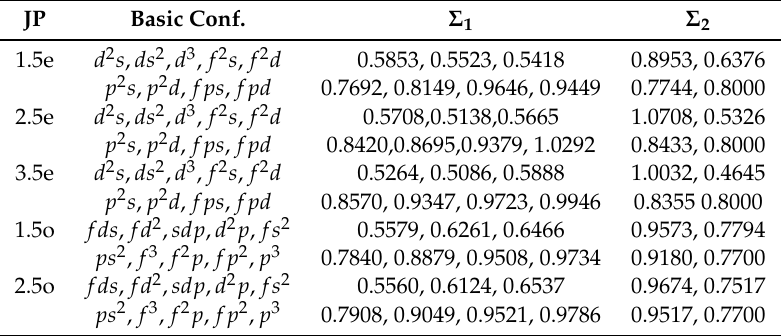
Table 1. Optimized parameters. Single and double excitations of basic configurations “Basic Conf.” were limited by 11s,11p,10d,9f. In the basic configurations listed “s” means 7s, “p” means 7p, f means “5f”, and “d” means 6d. The core states are the same.